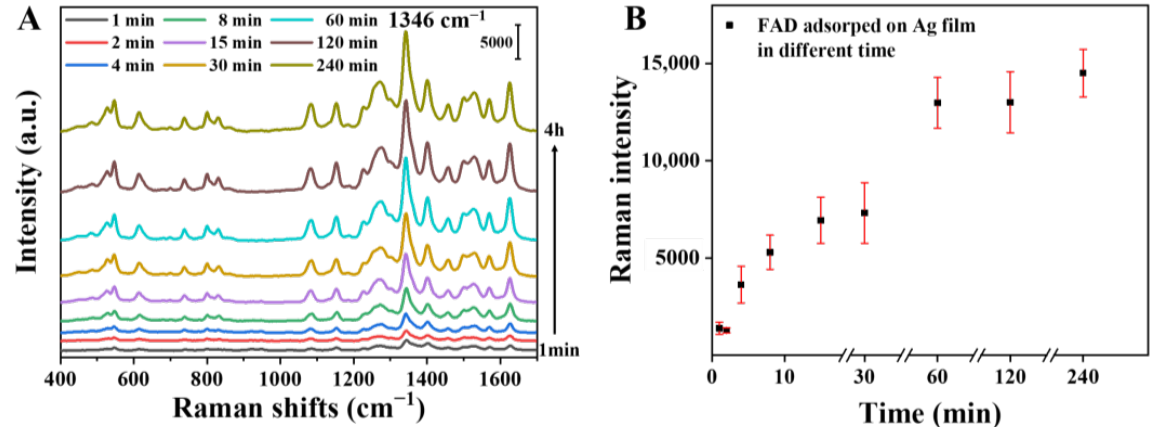
Figure 3. ( A ) The SERS spectra of 10 − 5 M FAD on Ag nanofilm at 1, 2, 4, 8, 15, 30, 60, 120, 240 min immersed time, respectively; ( B ) the adsorption curve of 10 − 5 M FAD on Ag nanofilm with respect to time based on 1346 cm − 1 .